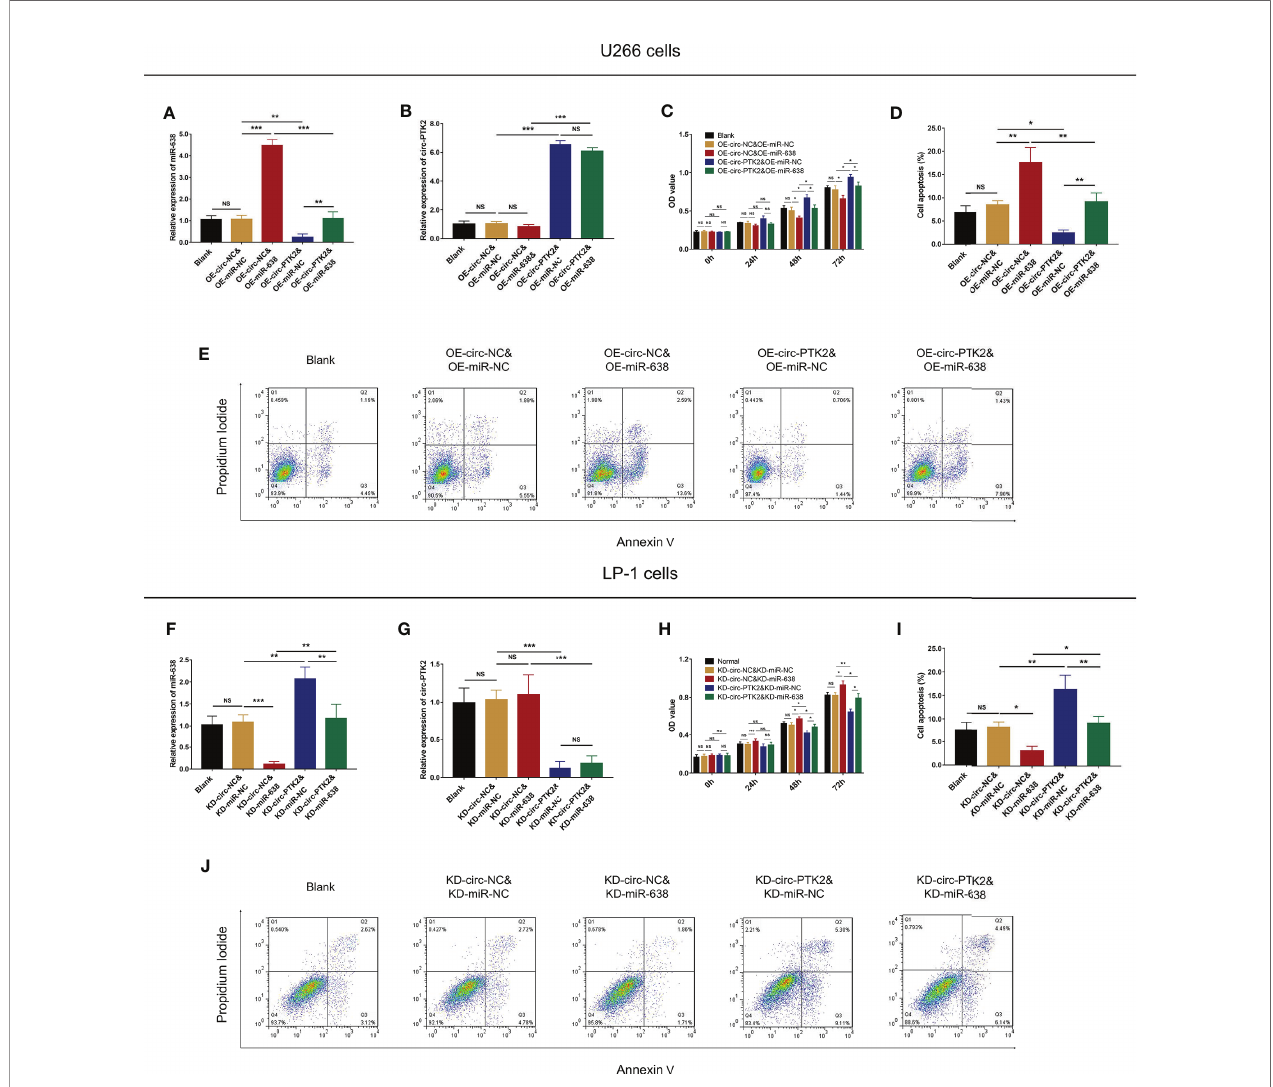
FIGURE 6 | Circ-PTK2 affected cell proliferation and apoptosis via regulating miR-638. Comparison of miR-638 expression (A) , circ-PTK2 expression (B) , cell proliferation (C) and cell apoptosis (D, E) detected by RT-qPCR, CCK-8 and AV/PI assays among different groups of U266 cells. Comparison of miR-638 expression (F) , circ-PTK2 expression (G) , cell proliferation (H) and cell apoptosis (I, J) detected by RT-qPCR, CCK-8 and AV/PI assays among different groups of LP-1 cells. Circ-PTK2, circular RNA protein tyrosine kinase 2; miR-638, microRNA 638; OD, optical density; NS, non-signi fi cant; RT-qPCR, reverse transcription quantitative polymerase chain reaction; CCK-8, counting kit-8; AV/PI, Annexin V/Propidium Iodide; OE-circ-NC, circRNA control overexpression; OE-circ-PTK2, circ-PTK2 overexpression; KD-circ-NC, circRNA control knock-down; KD-circ-PTK2, circ-PTK2 knock-down; OE-miR-NC, miRNA control overexpression; OE-miR-638, miR- 638 overexpression; KD-miR-NC, miRNA control knock-down; KD-miR-638, miR-638 knock-down plasmid; * P < 0.05; ** P < 0.01; *** P < 0.001. RNA expression was normalized by 2 - △△ Ct method. Experiments were performed in triplicates. The comparison was determined by One-way ANOVA followed by Tukey ’ s multiple comparison